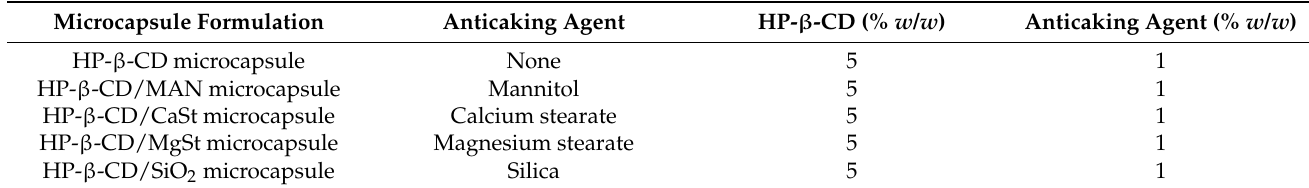
Table 4. Wall material ratio of microcapsules with different anticaking agents. Microcapsule